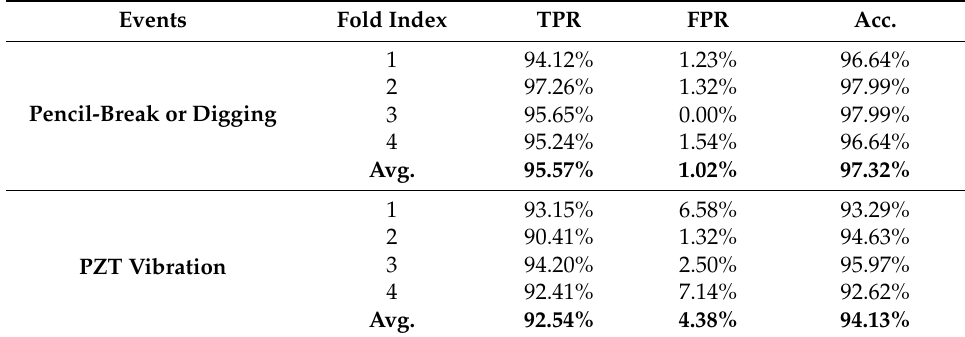
Table 3. The true positive rate (TPR), false positive rate (FPR), and accuracy (Acc.) of signal discrimination using SAK method. Events Fold Index TPR FPR Acc. 1 94.12% 1.23% 96.64% Pencil-Break or Digging